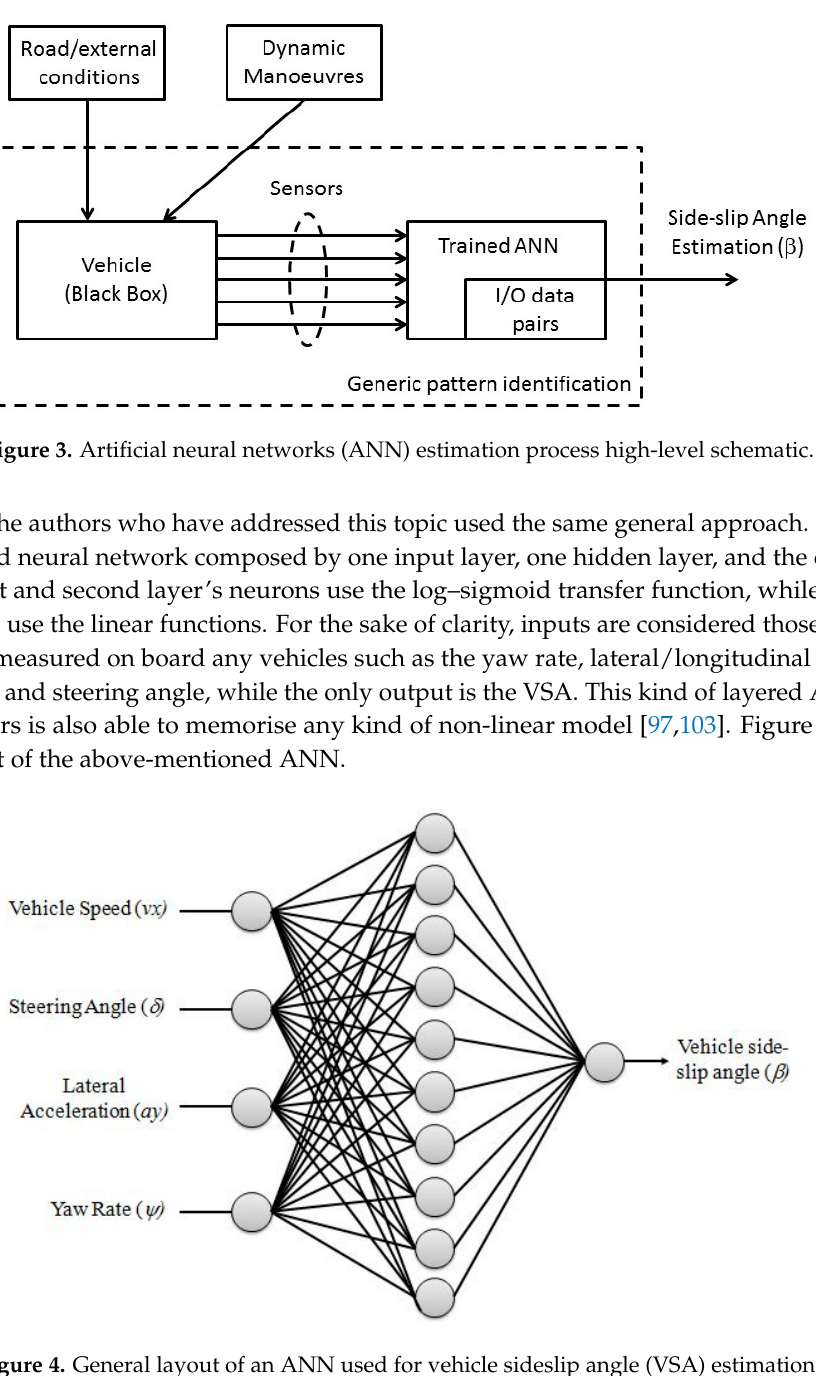
Figure 4. General layout of an ANN used for vehicle sideslip angle (VSA) estimation.